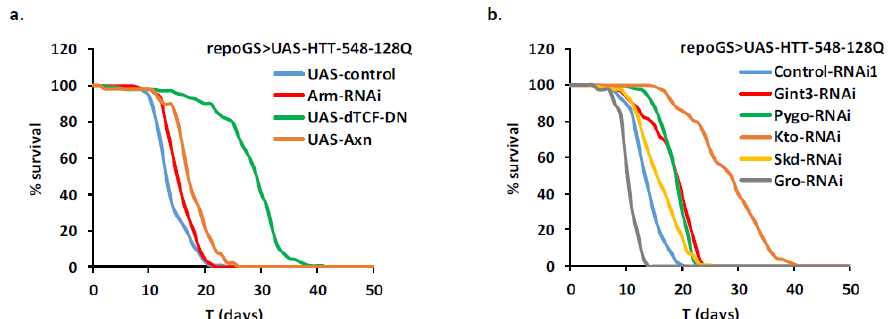
Figure 8. Identification of protective genetic interventions in the Wnt pathway. A repoGS > UAS- HTT-548-128Q line was crossed with transgenic lines allowing modulation of the Wnt pathway and the progeny (see Table S4 for detailed genotypes) was scored for their lifespan after induction with RU100. ( a ) Like in neurons, repression of the Wnt pathway in glial cells by depletion of arm (Arm-RNAi) and overexpression of a dominant negative dTCF gene (UAS-dTCF-DN) or of the Axin gene (UAS-Axn) are protective for mHTT toxicity (MLS = 27.4, 17.4; n = 142, 47; pLogRank < 10 −2 , 10 −10 , 10 −6 , respectively). Control flies: MLS = 13.3, n = 106. Note that repression of the Wnt pathway in glial cells by depletion of arm (Arm-RNAi) increased lifespan by only 11% (pLogRank < 10 −2 ), below our 20% threshold criterium. ( b ) Additional members of the pathway (Gint3, pygo, kto) also protected the flies from glial mHTT toxicity when depleted (MLS = 17.5, 17.9, 27.4, 15.2; n = 202, 170, 210; pLogRank < 10 −10 , 10 −10 , 10 −10 , respectively). Note that depletion of skd (Skd-RNAi) increased lifespan by 17% (pLogRank < 10 −8 ), below our 20% threshold criterium. In contrast, depletion of the groucho/TLE repressor (Gro-RNAi) reduced lifespan (MLS = 9.8; pLogRank < 10 −10 ; n = 37). Control flies: MLS = 13.0, n = 126.